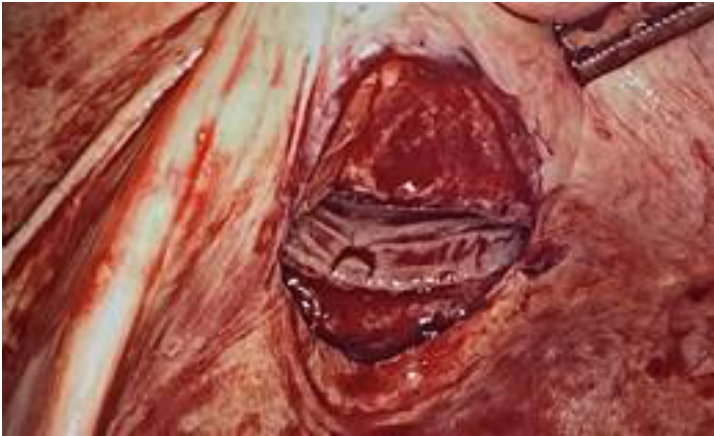
Figure 3. The laparoscopic view shows unincorporated and bleeding peritoneal edges.